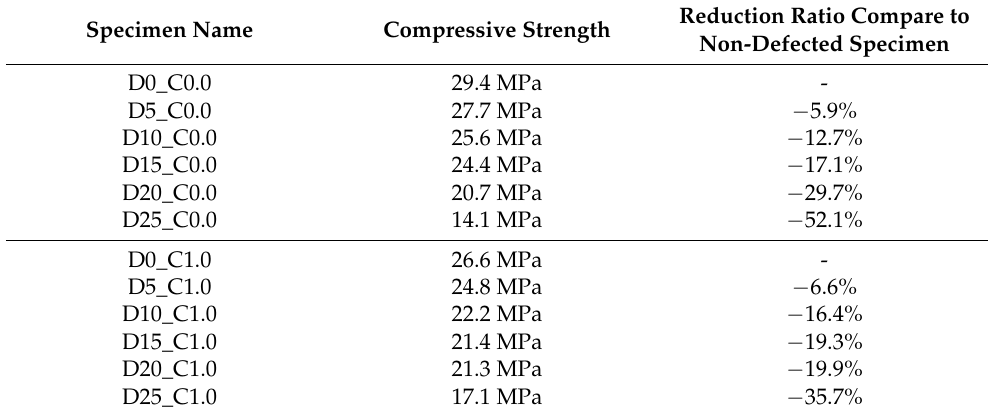
Table 3. Compressive strength of nano-cementitious composite on 30 curing